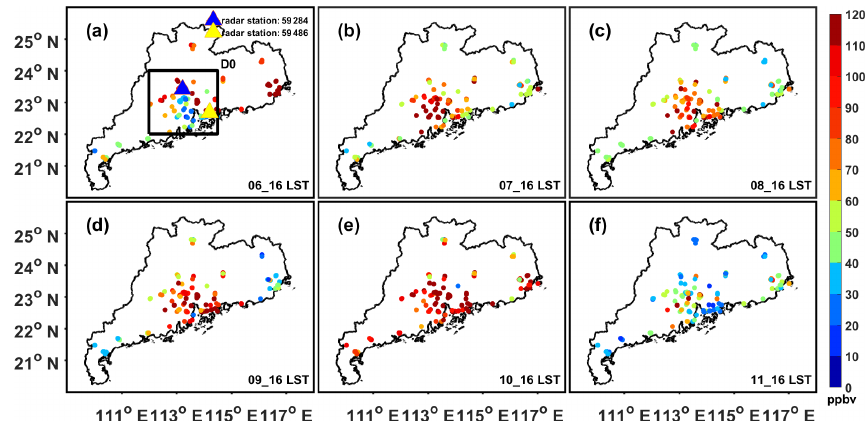
Figure 1. The horizontal distribution of surface ozone concentration over PRD at 16:00 from (a) 6 July 2016 to (f) 11 July 2016. The yellow and blue triangles in (a) denote the positions of wind profiler stations 59486 and 59284. The black box denoted D0 indicates the area where the severe ozone pollution event occurred.